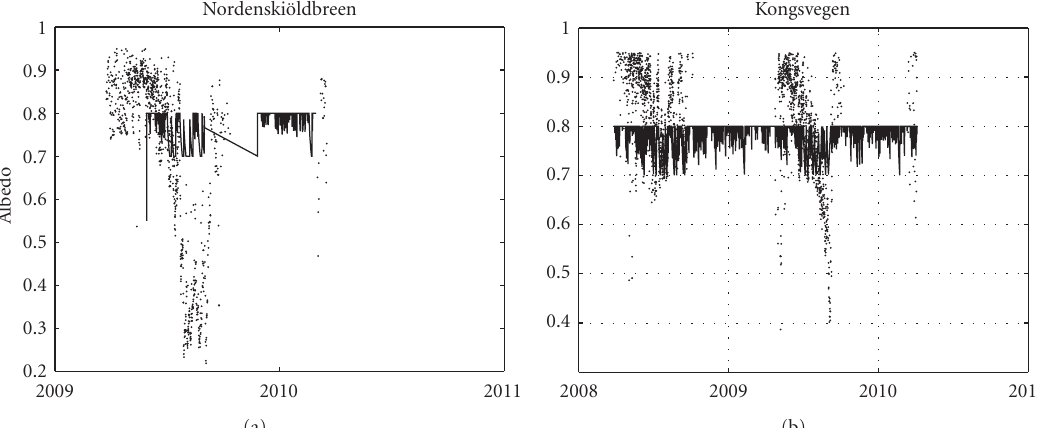
Figure 5: Time series of the albedo at (a) Nordenski¨oldbreen and (b) Kongsvegen. Dots are measurements and line is WRF with 2.7 km